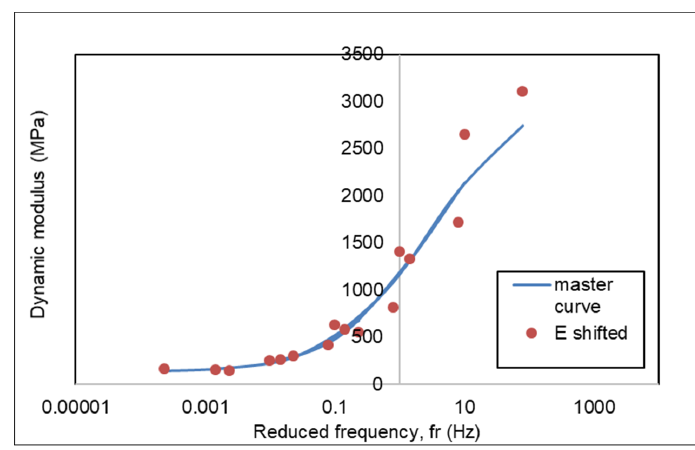
Figure 11. Master curve of HRS-WC mixture.